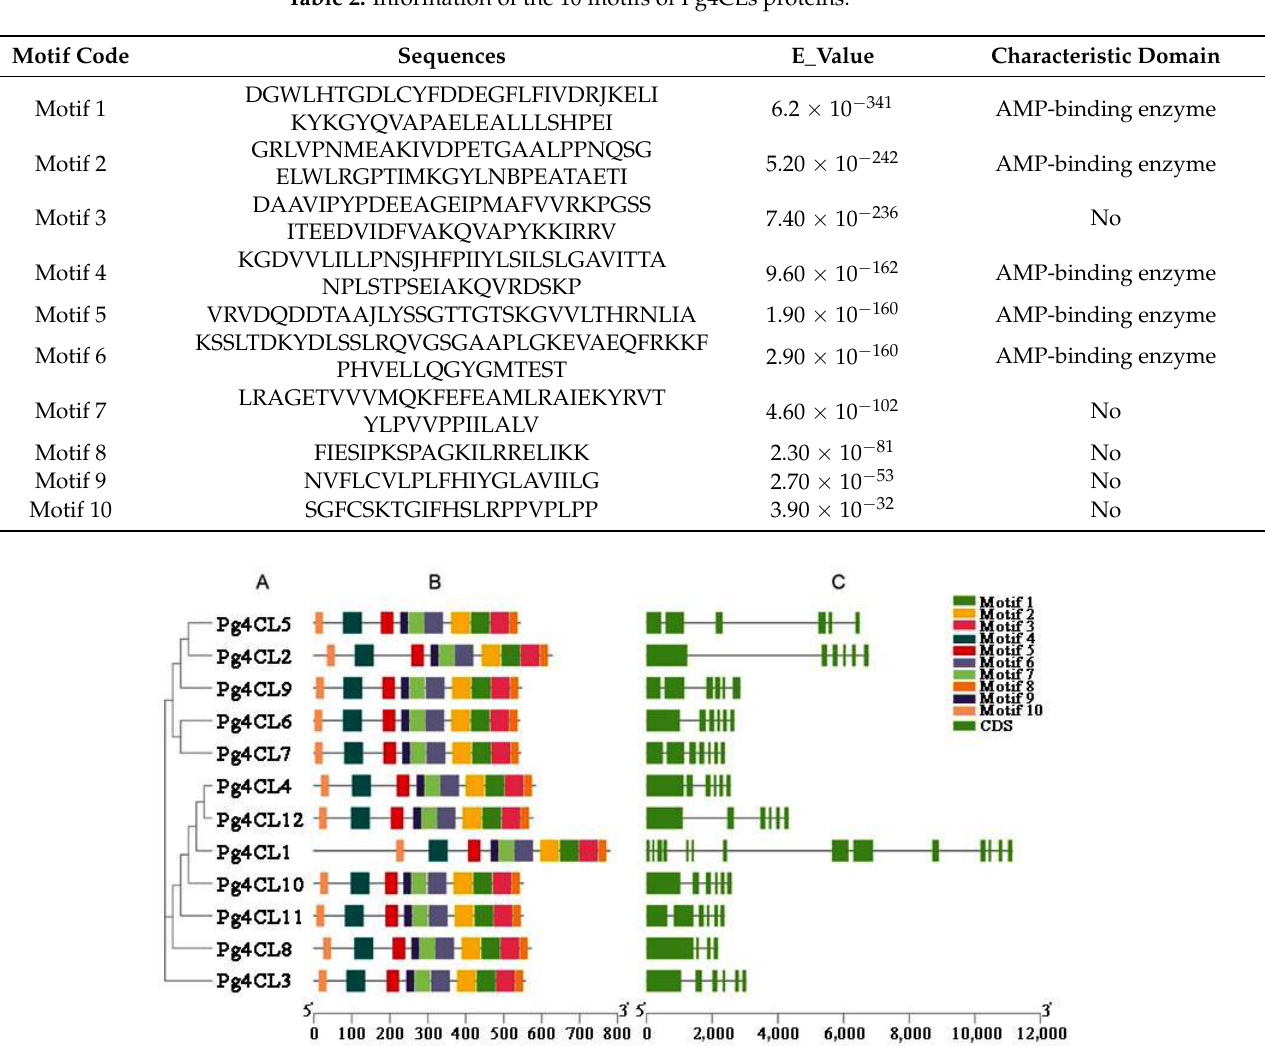
Table 2. Information of the 10 motifs of Pg4CLs proteins.